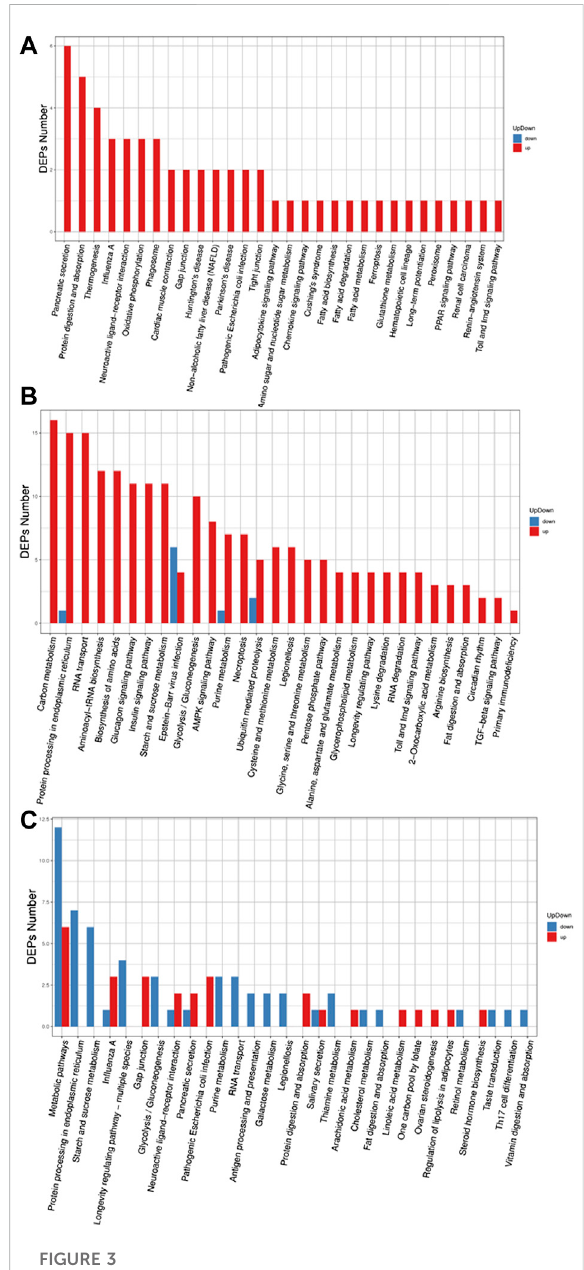
FIGURE 3 Barplot of the Gene Ontology analysis. (A) experiment II vs. experimentI, (B) controlIIvs.controlI, (C) experimentIIvs.control II.ThebarchartshowsthedistributionofcorrespondingGOterms. Different colors represent different GO